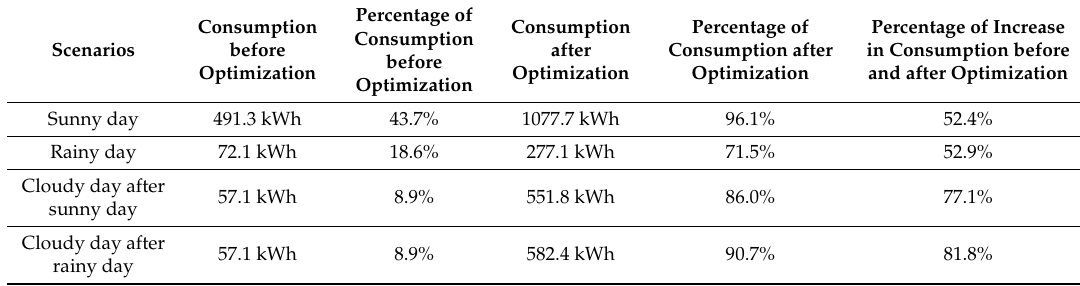
Table 6. Local photovoltaic power consumption results after